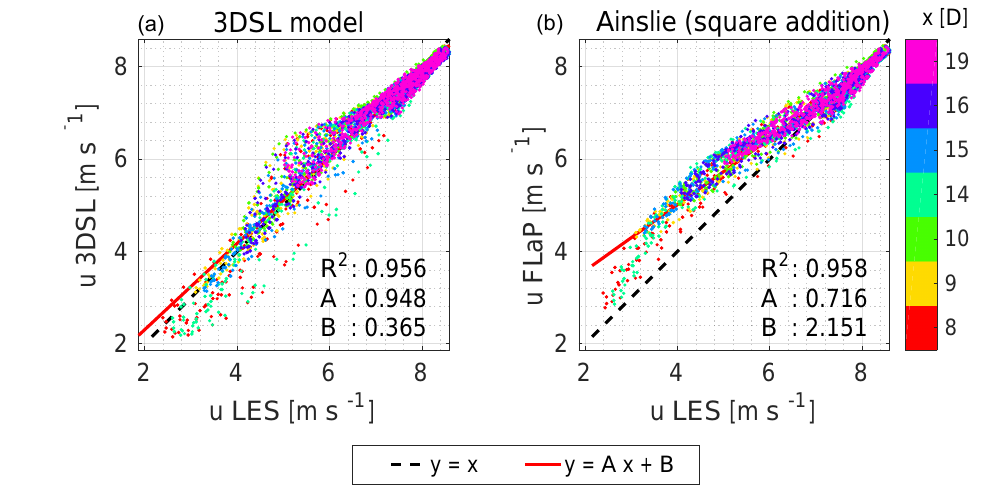
Figure 10. Test case 3 (multiple wakes with a 0.5 D lateral separation). Scatter plot and corresponding regression line of the wind speed derived from the 3DSL model (a) and from the FLaP wake simulations in relation to the reference wind field calculated with large-eddy simulations (LESs).